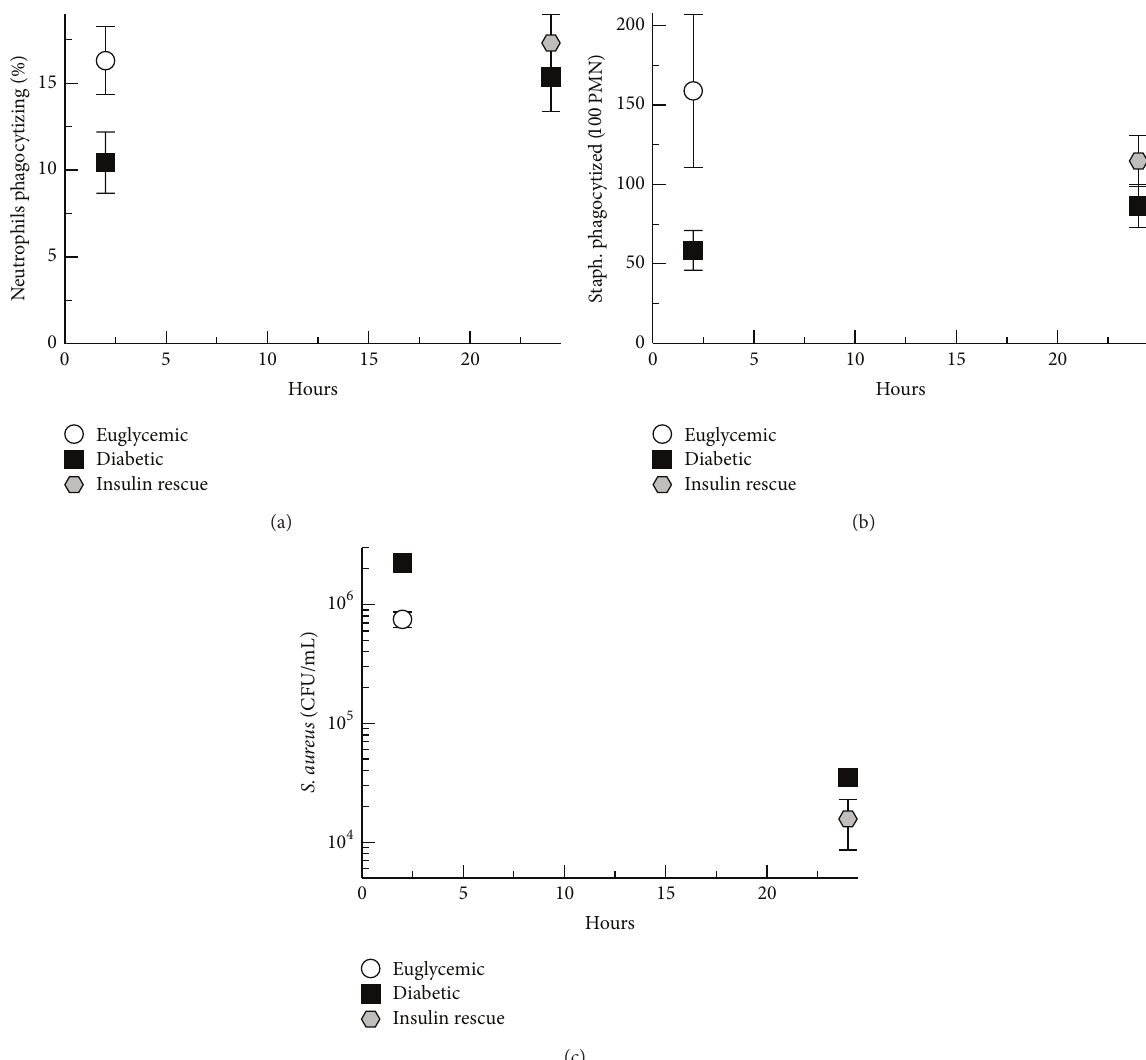
Figure 6: Neutrophil phagocytosis and S. aureus survival in the peritoneum. (a) Percent of neutrophils phagocytizing bacteria in peritoneal wash fluid assayed by fluorescence microscopy of acridine orange and crystal violet stained cytospin slides. (b) Bacteria phagocytized per 100 neutrophils in peritoneal wash fluid assayed by fluorescence microscopy of acridine orange and crystal violet stained cytospin slides. (c) S. aureus survival assayed by colony counting of peritoneal wash samples. Graphed data shows means of results for peritoneal samples from the animals in each treatment group. Error bars denote standard error of the